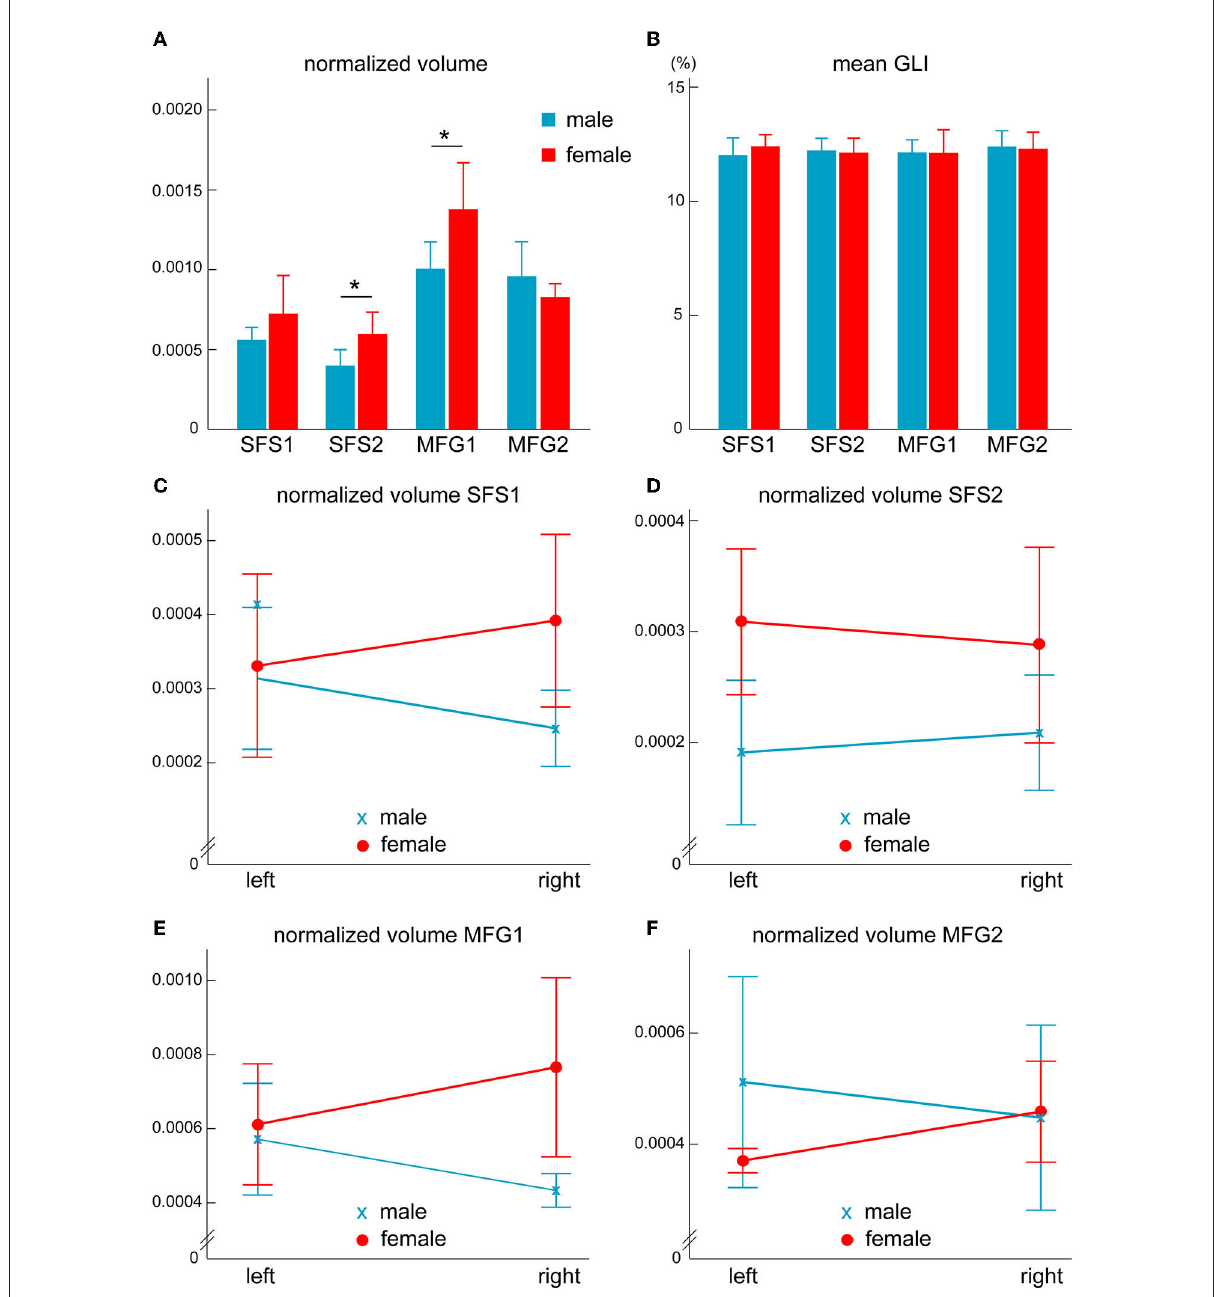
FIGURE11 Sex differences in anterior dorsolateral prefrontal cortex areas. Normalized volumes of areas SFS2 and MFG1 differ significantly between sexes [* p < 0.05, (A) ]. However, no sex differences were found in the volume fraction of cell bodies (B) . Analysis divided by hemispheres (C–F) revealed significantly higher area volumes ( p < 0.05) in female than in male brains in the right hemisphere of area SFS1 (C) and MFG1 (E) and in the left hemisphere of area SFS2 (D) . Normalized area volumes and GLI are presented as Mean ± SD.